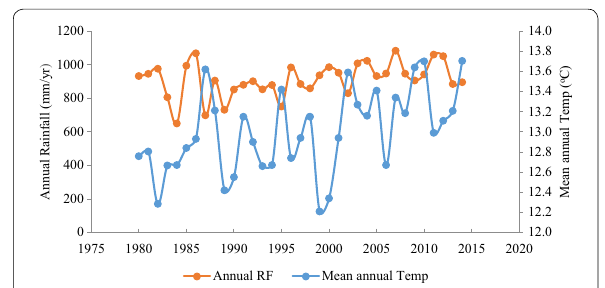
Fig. 8 Annual rainfall and temperature variability